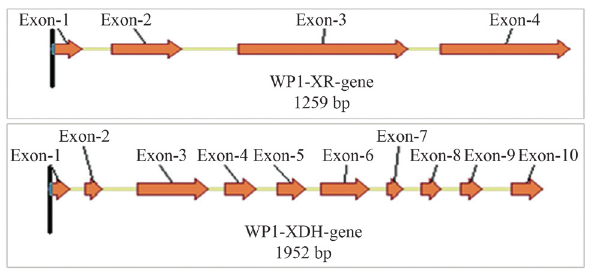
Figure 2 - Exon/intron structures visualization of XR and XDH-enco- ding-genes of the Rhodotorula graminis WP1